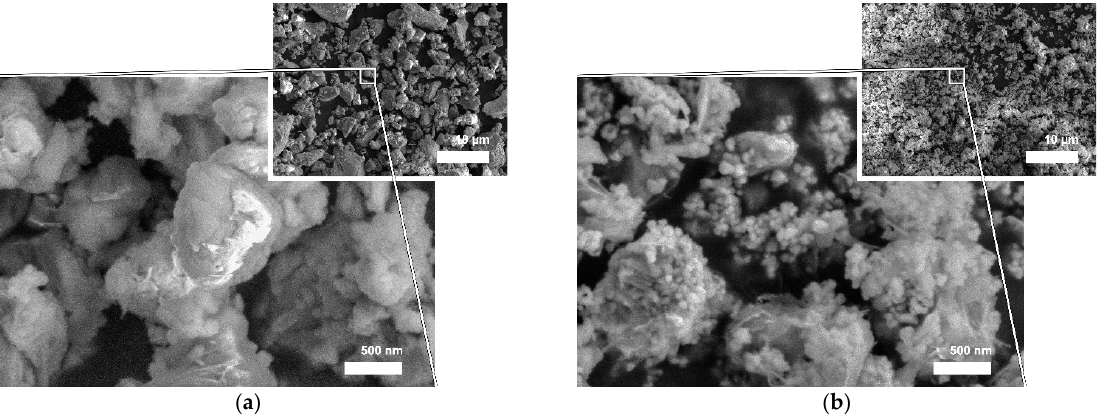
Figure 2. SEM micrographs showing the powder morphology, agglomeration state, and particle size: ( a ) ProRoot MTA and ( b ) RS+. ( a ) ProRoot MTA and ( b )